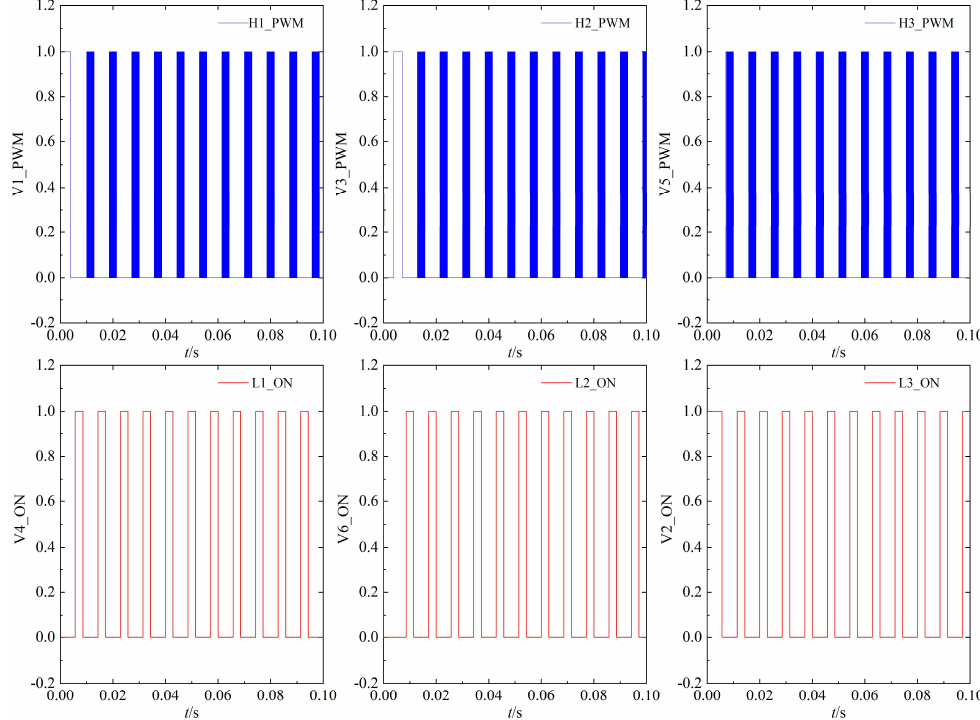
Figure 7. Logical state of Mosfet under FSNNN PID algorithm.